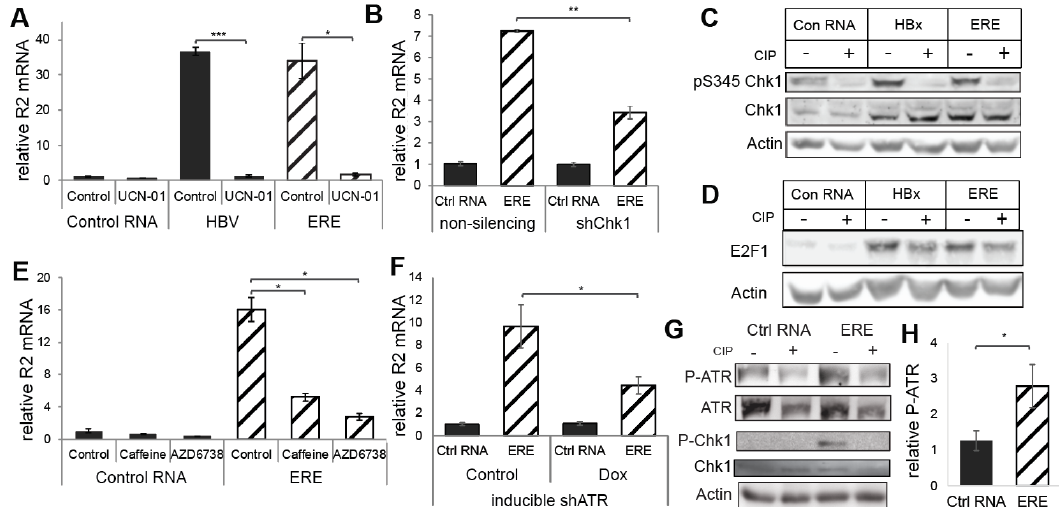
Figure 3. ERE activates the ATR-Chk1-E2F1 DNA damage response axis. ( A ) Non-cycling HepG2 cells were transduced with the indicated constructs and treated with 1 µM UCN-01, an inhibitor of Chk1 kinase activity, for 24 h. Relative RNR-R2 mRNA levels were measured by qRT-PCR from three biological replicates. ( B ) Non-cycling HepG2 cells, expressing shChk1 or non-silencing shRNA were transduced with control RNA or ERE. Relative RNR-R2 mRNA levels were measured by qRT-PCR from three biological replicates. Student’s t -test was performed, * p -value < 0.05, ** p -value < 0.01, and *** p -value < 0.001. The p -value for the non-silencing is 0.00001, the p -value for shChk1 is 0.02090 and the p -value between ERE non-silencing and shChk1 is 0.008217. ( C , D ) Quiescent HepG2 cells were transduced with LV containing the indicated constructs, control RNA, full length HBV, and ERE. Phospho-S345 Chk1 and Chk1 ( C ) and E2F1 ( D ) levels were measured by Western blot, using a specific antibody, and the phosphorylated nature of the bands was validated by Calf Intestinal Phosphatase (CIP) treatment. Actin protein levels were measured as control. ( E ) Non-cycling HepG2 cells were transduced with LV-constructs containing ERE or control RNA. After 48 h, cells were treated with 2 µM Caffeine or 10 µM AZD6738, a specific ATR inhibitor, or left untreated. RNR-R2 mRNA levels were measured 24h after treatment with qRT-PCR from three biological replicates. Student’s t -test was performed comparing the control of each sample to the treatments. * p -value < 0.05 ( F ) A HepG2-based cell line that expresses ATR shRNA under a Doxycycline (Dox)-inducible promoter was created. These cells were DMSO treated to be quiescent, transduced with ERE or control RNA and treated with 1ug/mL Dox for 3 days. R2 mRNA levels from three biological replicates were measured by qRT-PCR. * p -value < 0.05 ( G ) PhosphoT1989 ATR, PhosphoS345 Chk1, Chk1, and total ATR levels were examined in the presence and absence of ERE by Western blot. CIP was used to evaluate the specificity of the phospho-antibodies. Actin was used as loading control. H ) Quantification of P-ATR levels of five biological replicates of experiment described in G. * p -value < 0.05 .